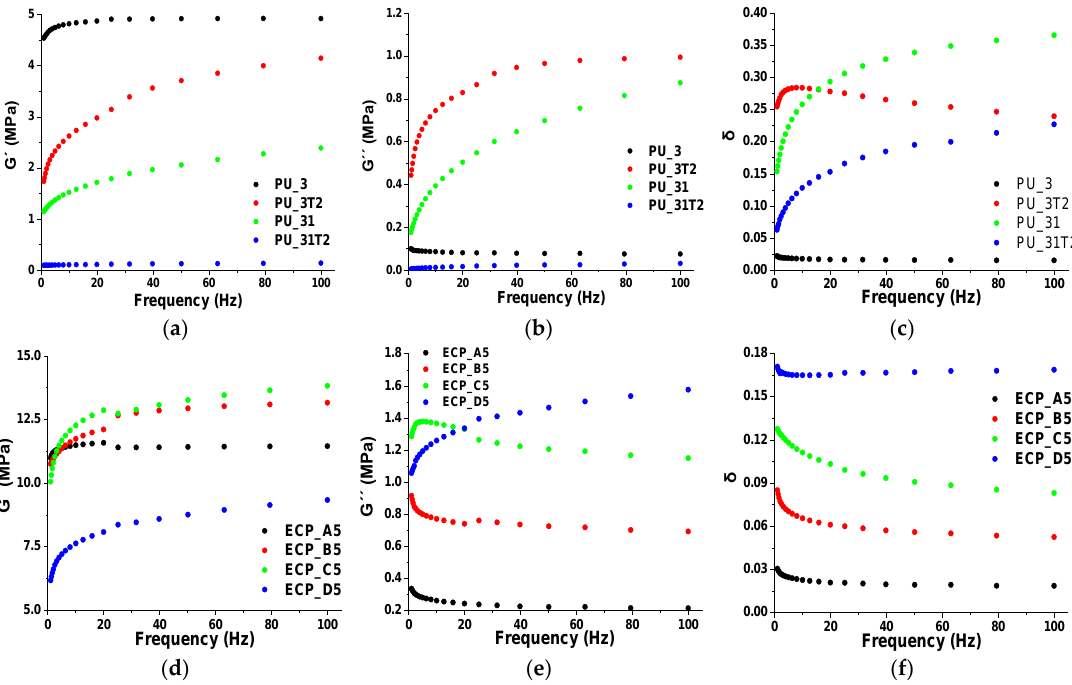
Figure 9. Shear storage modulus ( a , d ), shear loss modulus ( b , e ), and tan delta ( c , f ) profiles vs. frequency for synthesized polyurethanes and for the corresponding composite propellants.